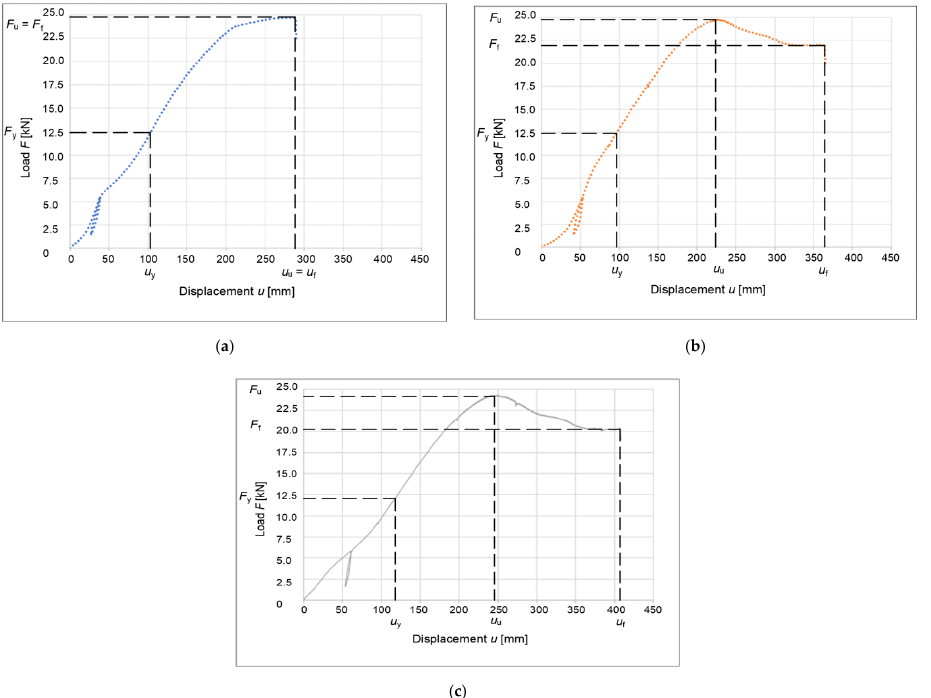
Figure 22. Graphical representation of the yield strength of a connection formed with screws ac- cording Karacabeily and Ceccotti (1998): ( a ) unreinforced specimen; ( b ) reinforced partitions; and ( c ) reinforced rung and struts (stands).